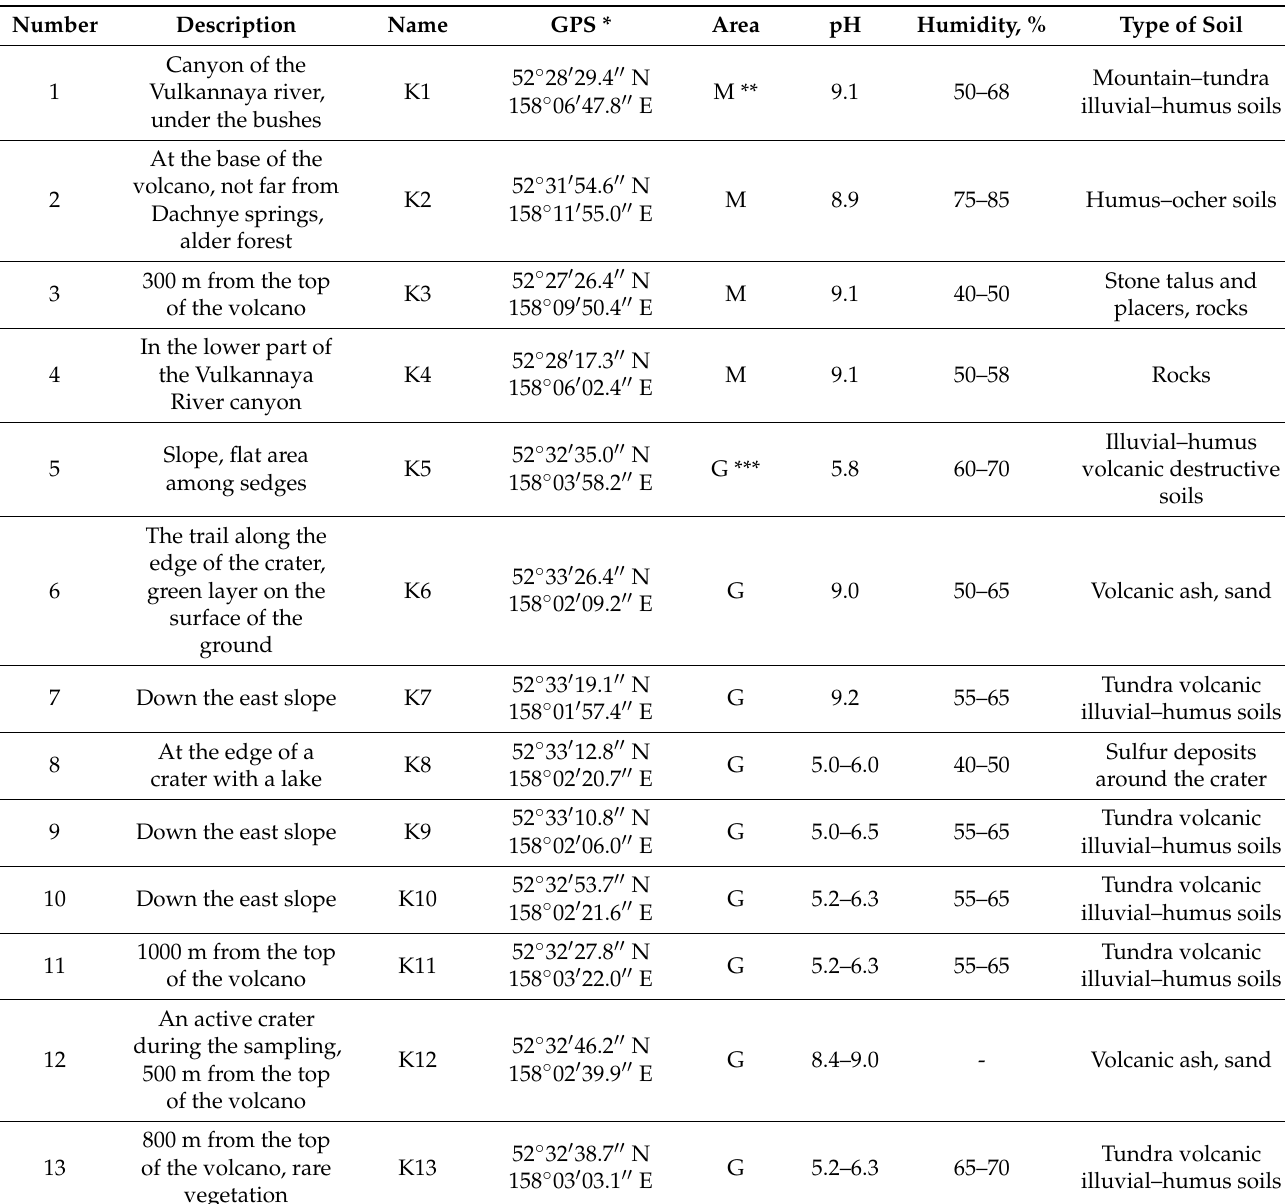
Table 2. Sampling